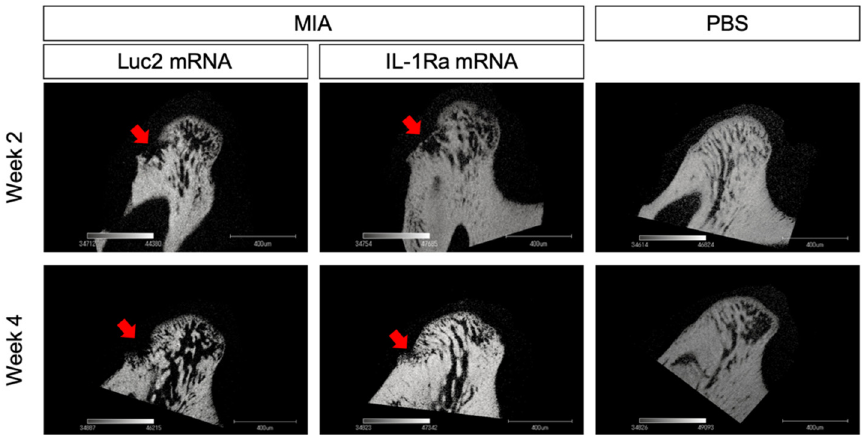
Figure 5. Radiographic changes in the condylar subchondral bone. Micro-CT images of the sagittal view of the condyles of monosodium iodoacetate (MIA)-treated temporomandibular joints (TMJs) with receiving luciferase 2 (Luc2) or interleukin-1 receptor antagonist (IL-1Ra) mRNAs, as well as PBS-treated TMJ. Arrows indicate the bone erosion on the surface of the condyle.